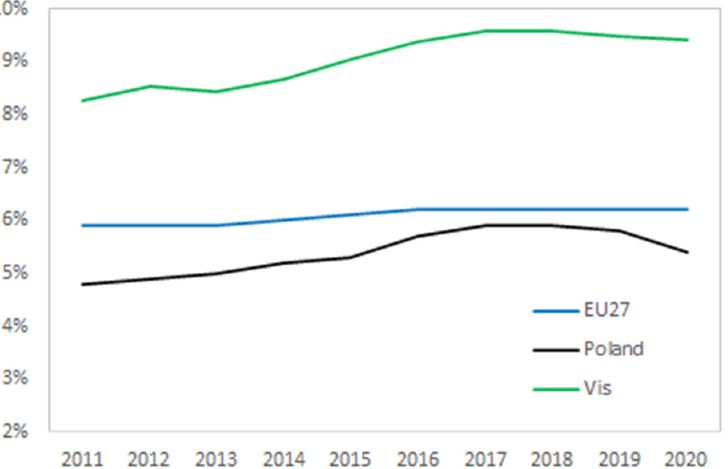
Figure 12. Human resources in science and technology. Employment in ICT sector and technology manufacturing. Percentage of total employment. Source of data: EUROSTAT manufacturing. Percentage of total employment. Source of data: EUROSTAT [38].